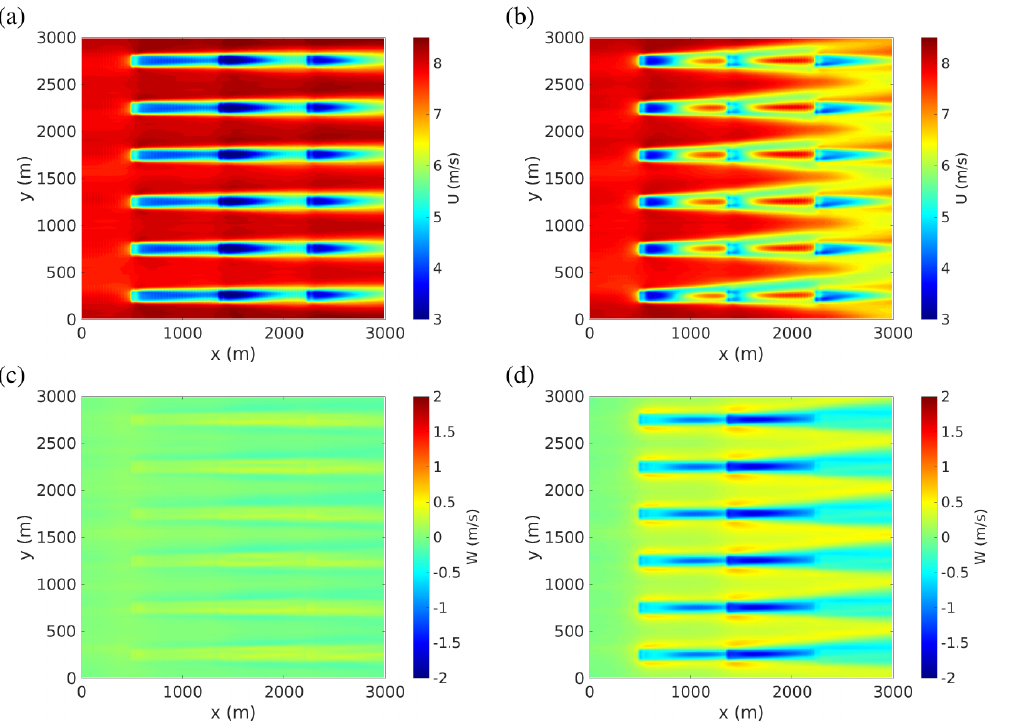
Figure 3. Time-averaged streamwise velocity fields (a, b) and vertical velocity fields (c, d) in the horizontal plane at hub height ( z h = 89m) for the simulations of the D = 126m wind-turbine arrays in the H = 750m ABL. The incoming mean wind is from the west (shown coming from the left in all panels). Panels on the left (a, c) pertain to the reference case, while right panels (b, d) pertain to the case where rotors of = 3. the upwind and middle arrays are tilted by ϕ = 30 ◦ and operated at C (cid:48) T